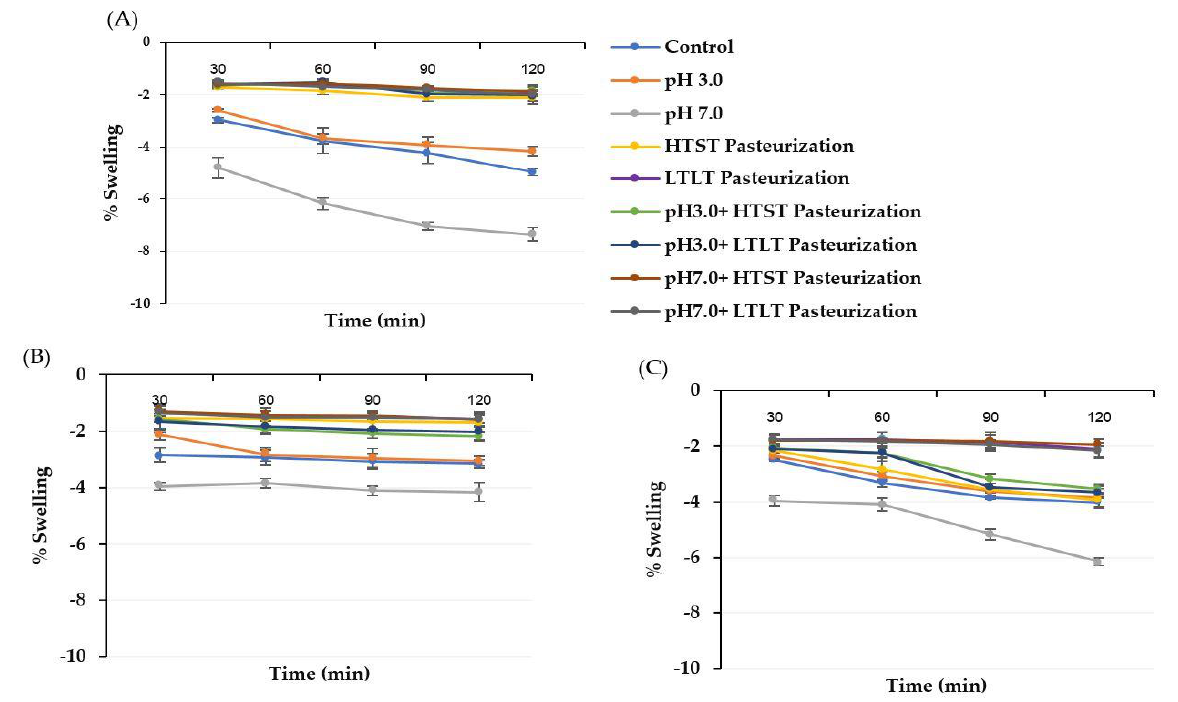
Figure 2. % Swelling of treated CA ( A ), CM ( B) , and CI ( C) hydrogel beads under SGF. The negative swelling percentage ( − ) indicates shrinkage behavior after the treatment. The error bars indicate the SD of the data.